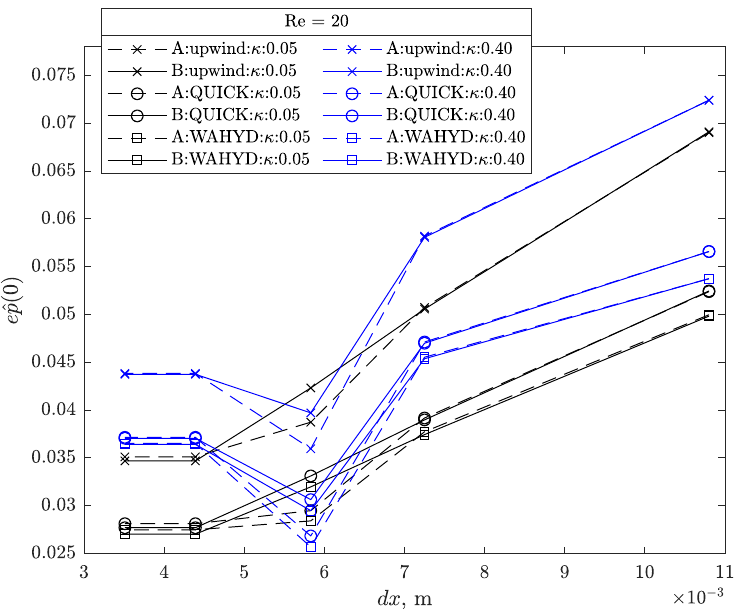
Figure 29. Dimensionless pressure error at θ = 0 as function of grid size for the flow around a cylinder case with Re =